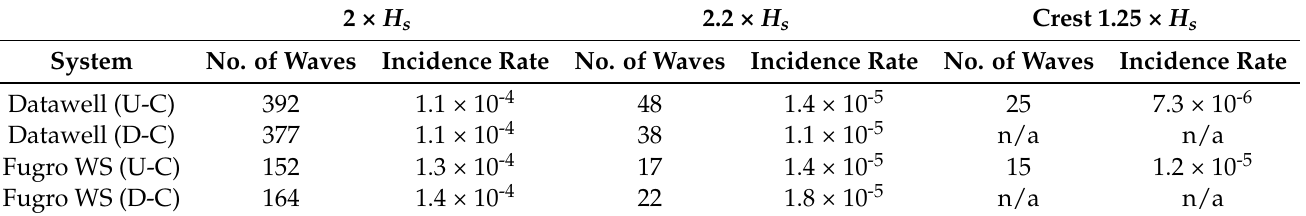
Table 3. Rogue wave incidence rates at M6 calculated from raw data for each sensor, method of calculation and rogue definition. The absolute number of rogue waves is higher for Datawell due to its longer sampling window capturing more individual waves—further details in text.